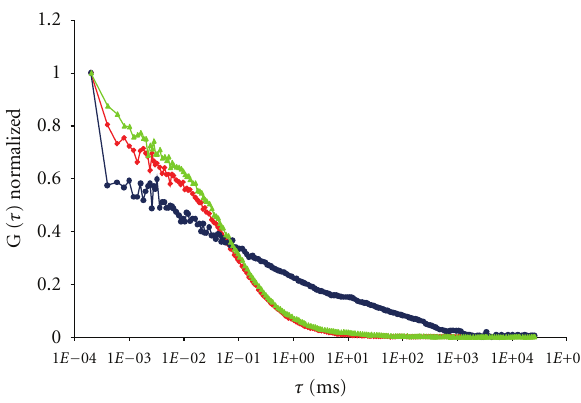
Figure 2: Comparison of autocorrelation curves of the Alexa532- ET1 (14.3nM) binding to the ET A receptor on living A10 cells. Con- trol experiments (blue), coincubation with 1 μ M BQ-123 (green) leads to an autocorrelation curve similar to that of the free ligand (red) indicating the displacement of the bound Alexa532-ET1.